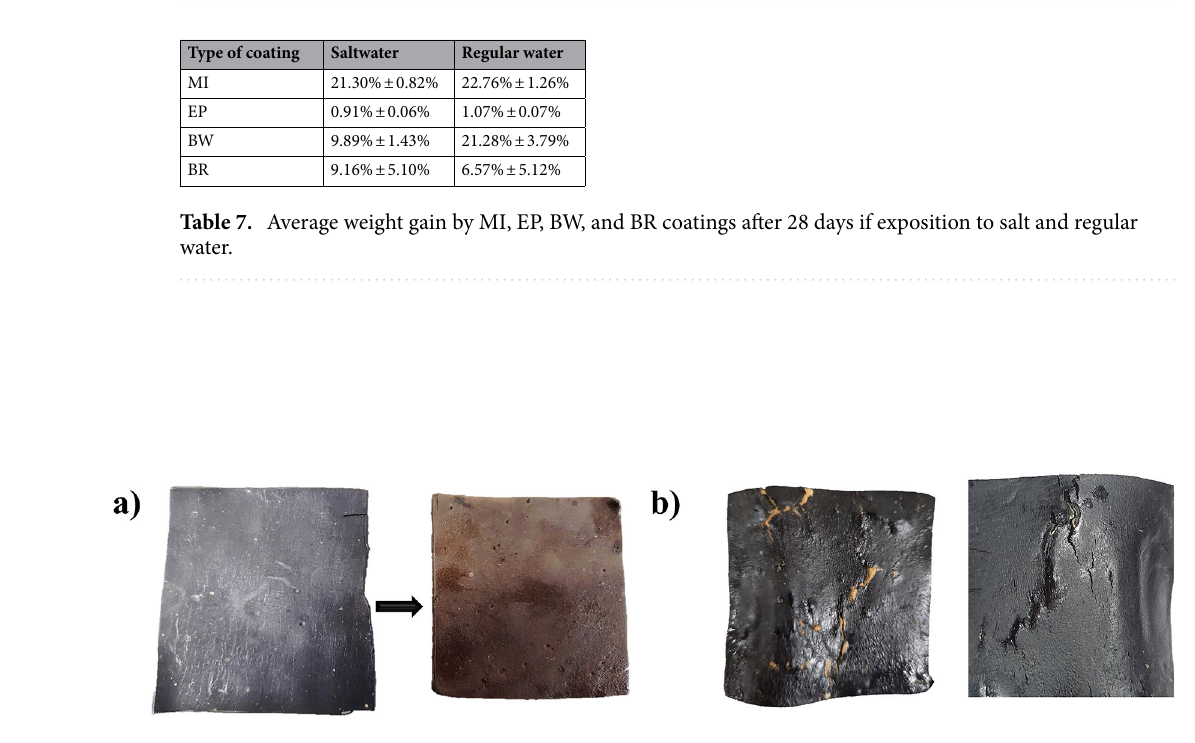
Figure 13. Physical changes in BW coating after 28 days of exposition ( a ) Produced by exposition to regular water ( b ) Produced by exposition to